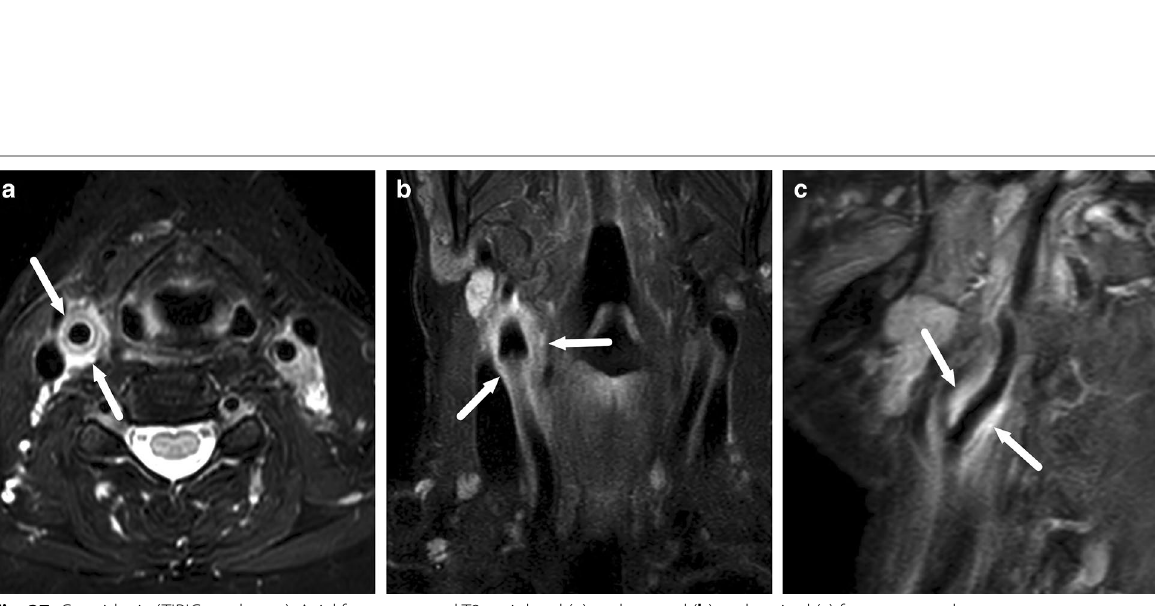
Fig. 37 Carotidynia (TIPIC syndrome). Axial fat-suppressed T2-weighted ( a ) and coronal ( b ) and sagittal ( c ) fat-suppressed post-contrast T1-weighted images show inflammation in and around the right carotid